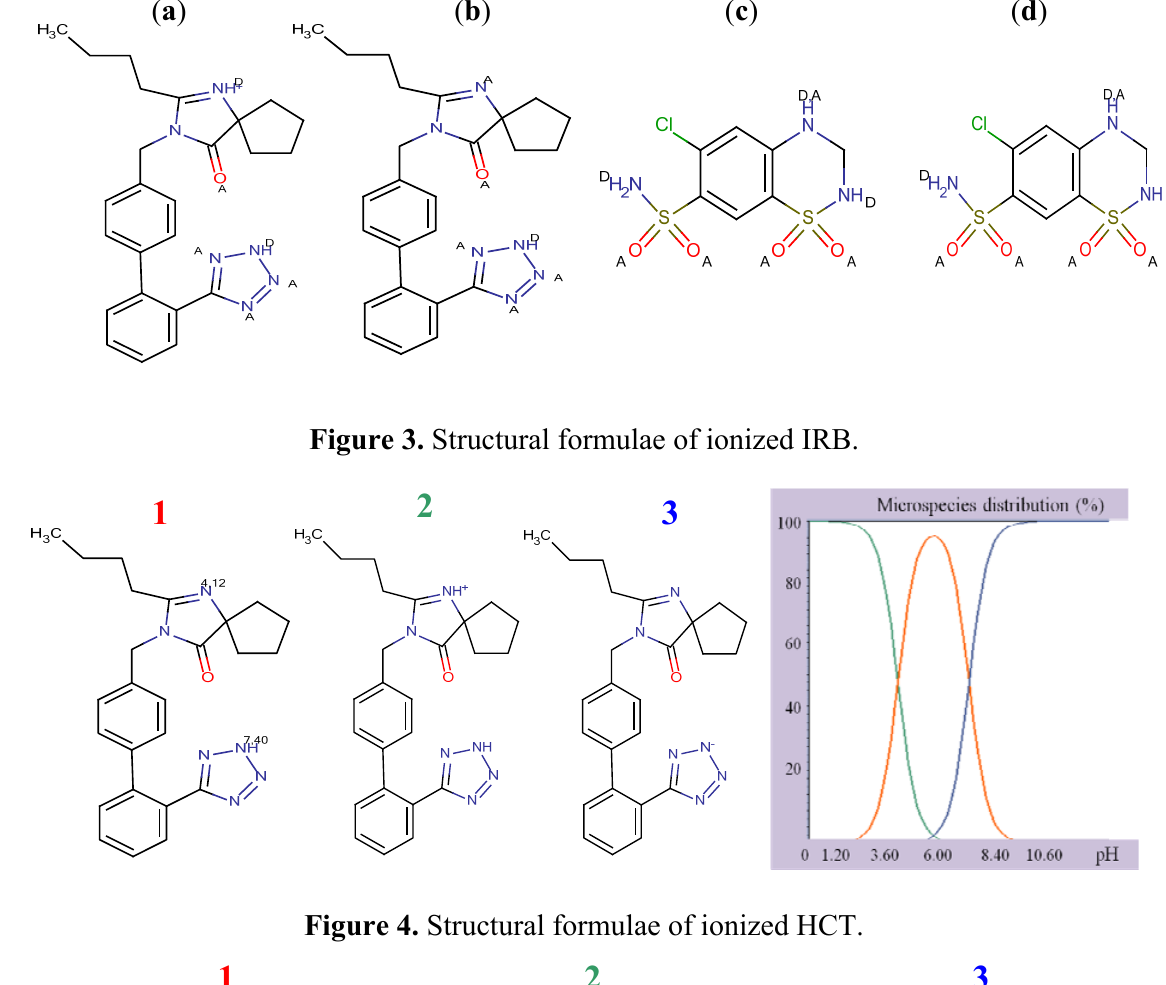
Figure 2. Proton acceptor (A) and donor groups (D) of IRB and HCT at pH 4 ( a , c ) and pH 6 ( b , d ).